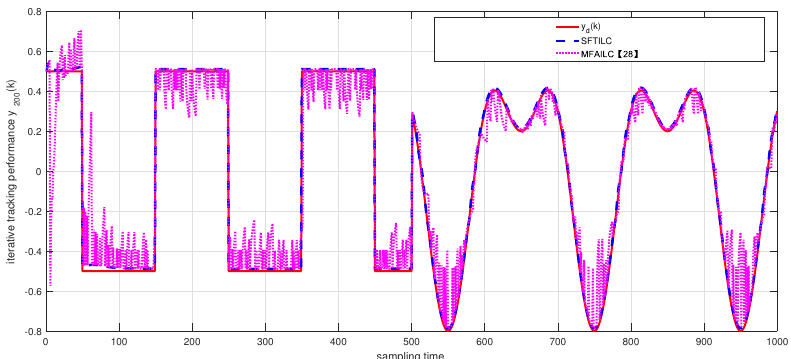
Figure 6. Tracking